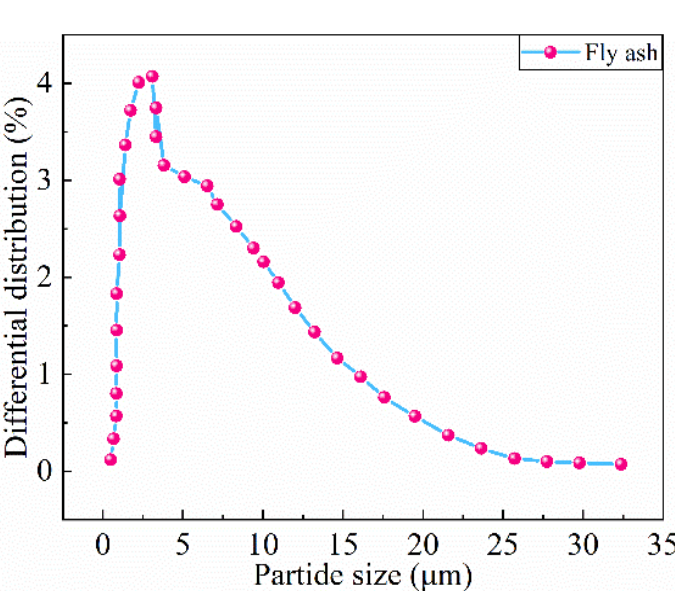
Figure 3. Particle size diagram of fly ash. Table 4. Chemical constitution of fly Table 3. Chemical constitution of ceramic powder.